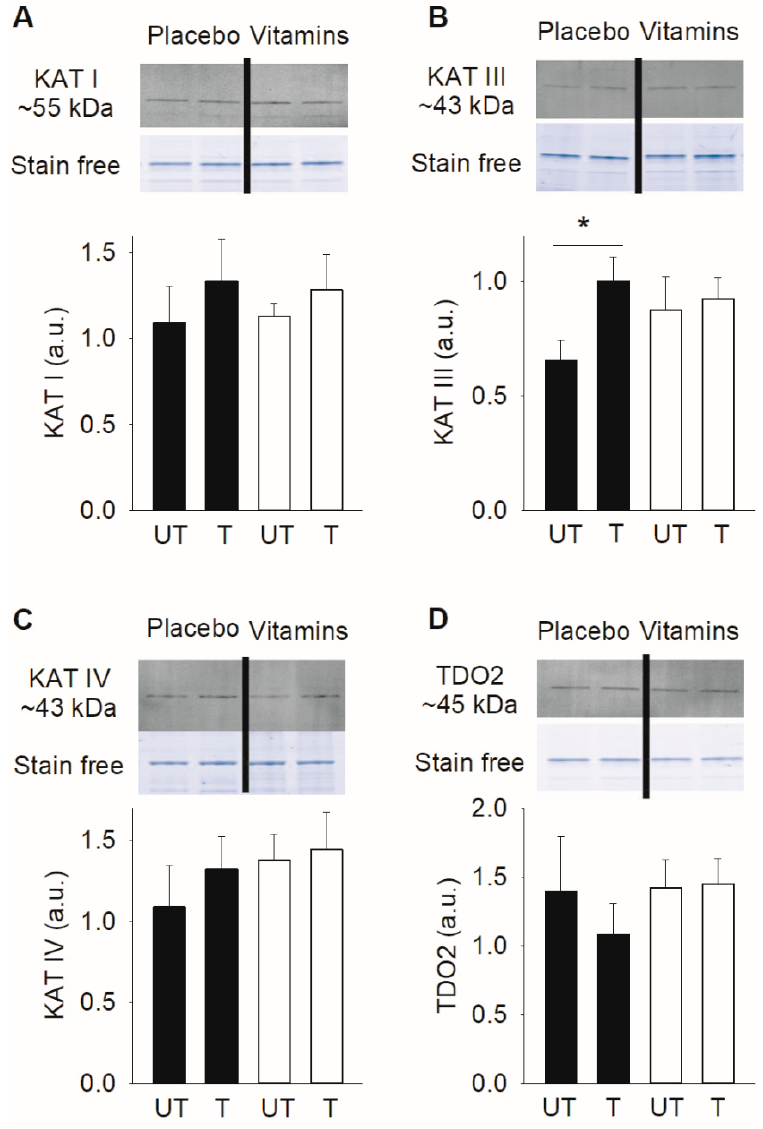
Figure 4. Three weeks of SIT increased KAT III protein expression in the placebo but not in the vitamin-treated group. Mean data ( ± SEM) and representative blots for ( A ) KAT I, ( B ) KAT III, ( C ) KAT IV, and ( D ) TDO2 in skeletal muscle biopsies taken under resting conditions in the untrained (UT) and trained (T) states. Black bars, placebo group ( n = 7–8); white bars, vitamin-treated group ( n = 8–9). Stain free images were used as total protein loading controls and the actin band in such stain free images reflected the total protein content and are shown below the Western blots. Each protein was normalized against its own calibration curve (~5–40 μ g wet weight protein) and expressed relative total protein loading. * p < 0.05 between untrained and trained state with two-way repeated measures ANOVA followed by Tukey’s post-hoc test.